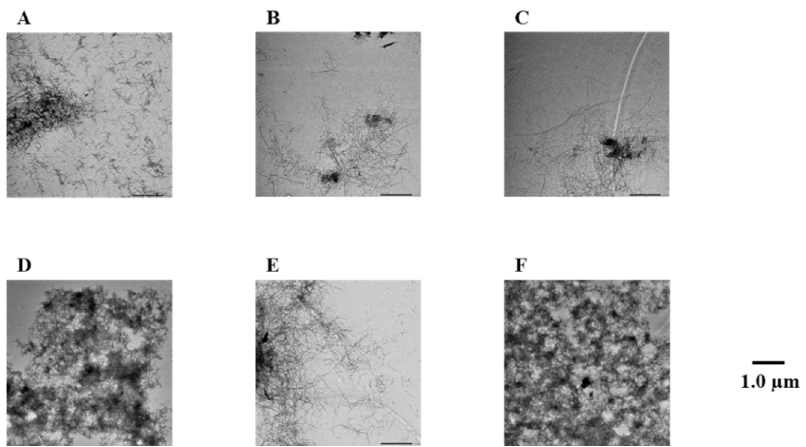
Figure 3. Efficacy of compounds 1 , 3 , 5 , 7 , and 8 against A β 42 fibril formation visualized by use of TEM. The formation of A β 42 fibrils was observed after incubation in 50 µ M PBS buffer for 24 h. Scale bar: 1.0 µ M. ( A ) A β 42 + 1 , ( B ) A β 42 + 3 , ( C ) A β 42 + 5 , ( D ) A β 42 + 7 , ( E ) A β 42 + 8 , and ( F ) A β